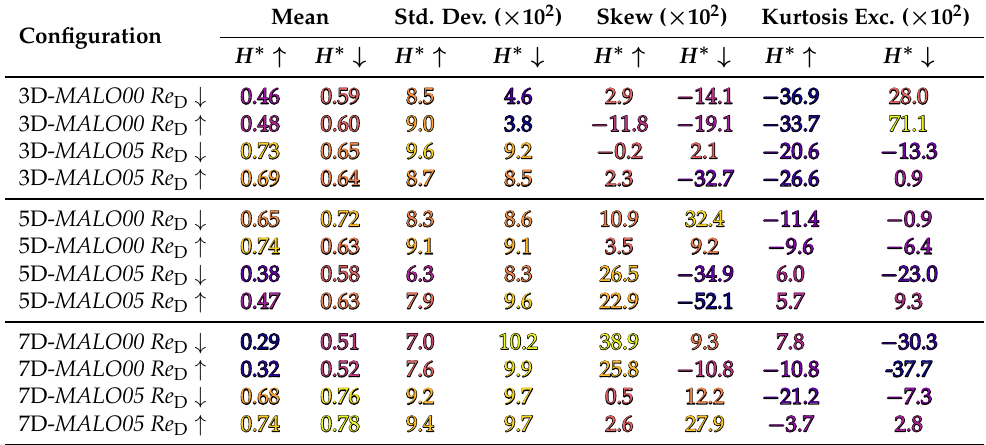
Table 3. Jet statistics at two different height locations for jet velocity magnitude, normalized with time-averaged maximum velocity magnitude at each configuration. Color shows magnitude relative to data in each major column (dark is